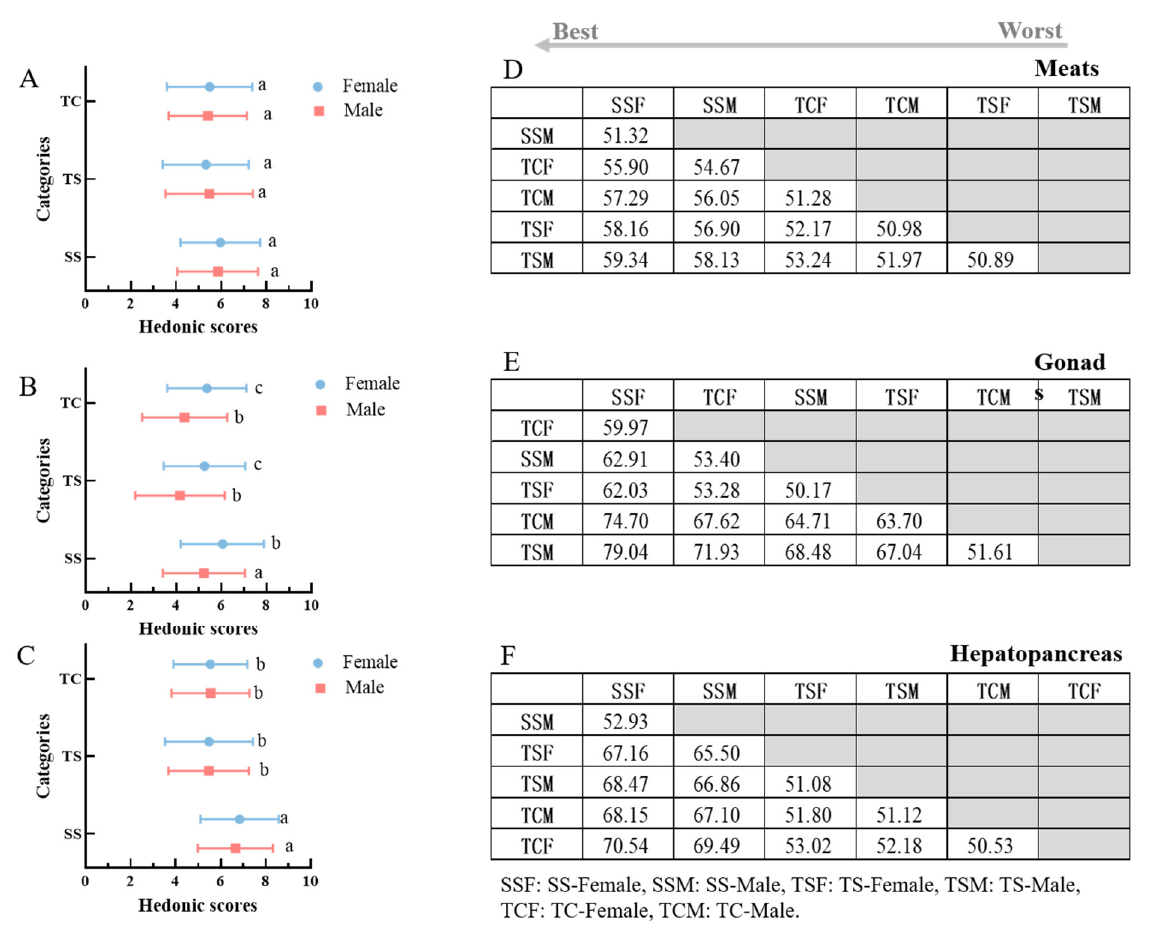
Figure 3. Overall consumer preference assessment of the odor profile for E. sinensis from three regions (N = 100). ( A,B, and C ) represent the mean and significance calculated using traditional ANOVA/LSD statistical analysis. ( D,E, and F ) are R-index values (R MAT ) calculated from the ranking data derived from the nine-point hedonic scale responses. ( A and D) represent data from crab meat, ( B and E ) represent data from gonads, and ( C and F ) represent data from the hepatopancreas. The R MAT index indicates a preference for the samples in the first row over the left column. For example, 51.32% of consumers in Figure 1D prefer I to II. A higher R MAT value indicated a more significant difference between the two samples. The first row of samples, arranged from left to right, indicates the preference from best to worst. Significant differences are indicated by lowercase letters (a, b and